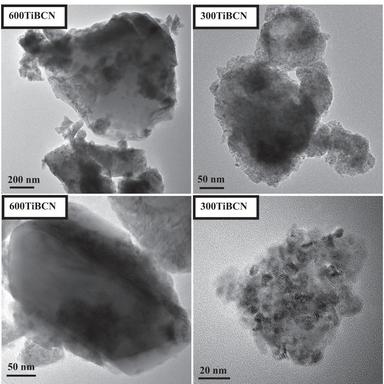
Transmission Electron Microscope (TEM) images for the 600TiBCN and 300TiBCN samples.